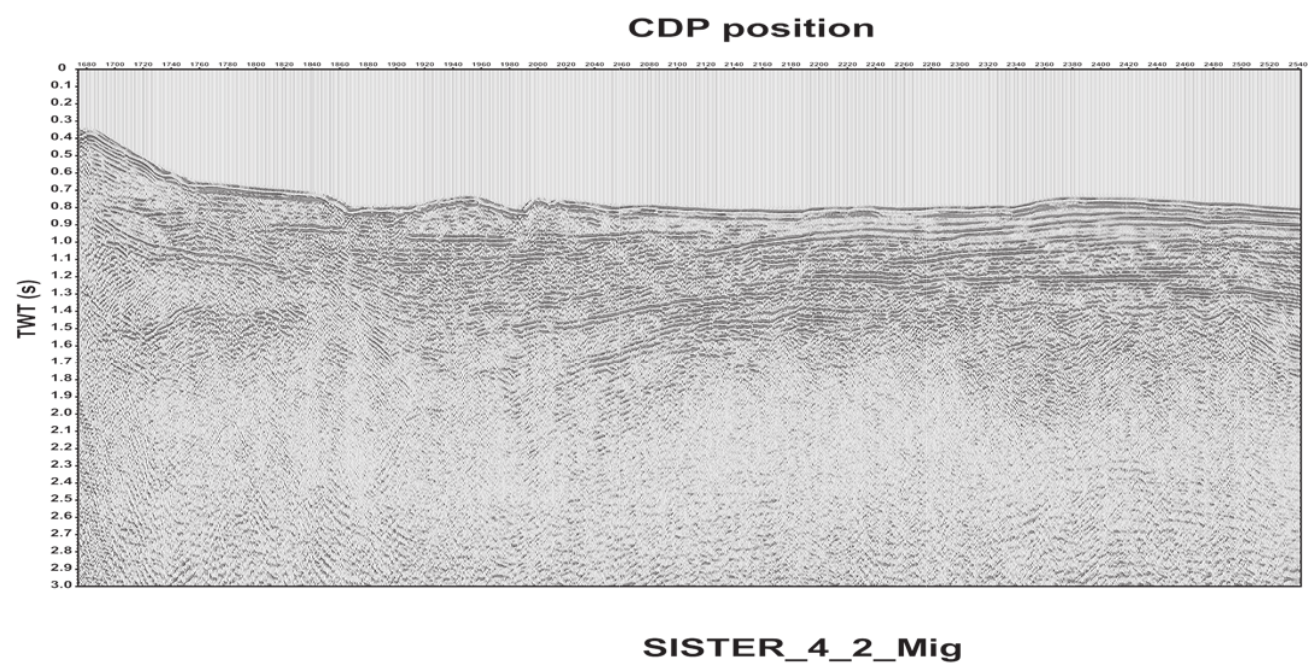
Figure 6. Sister4_2 seismic profile (Volturno Basin). See legend to Figure 7 for the geological interpretation of the seismic